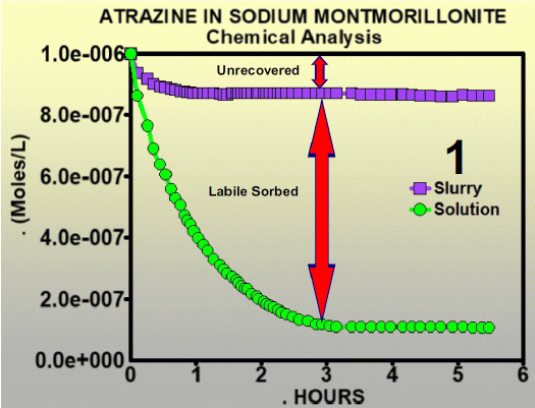
Figure 1. Chemical analysis of sodium montmorillonite suspension in an aqueous solution of atrazine. Initial concentration, 1.0 × 10 − 6 M. 4.0 (g/L) of montmorillonite 25.0 °C. The indicated subtractions produced the kinetics curves in Figure 2.